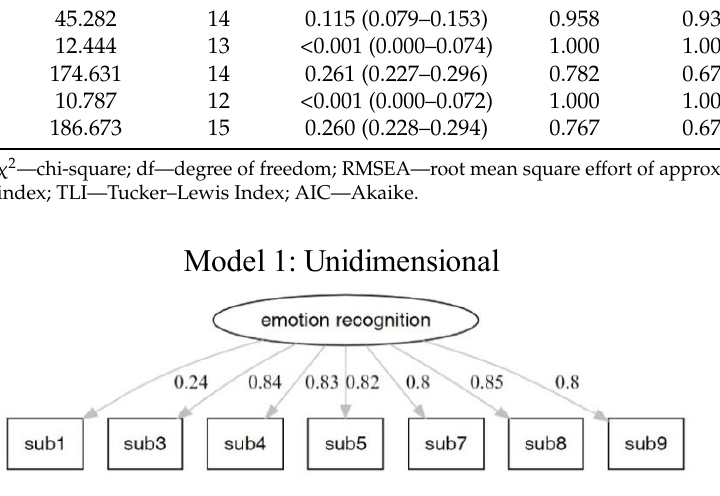
Figure 2. Model 1 is a one-factor (emotion recognition) model.